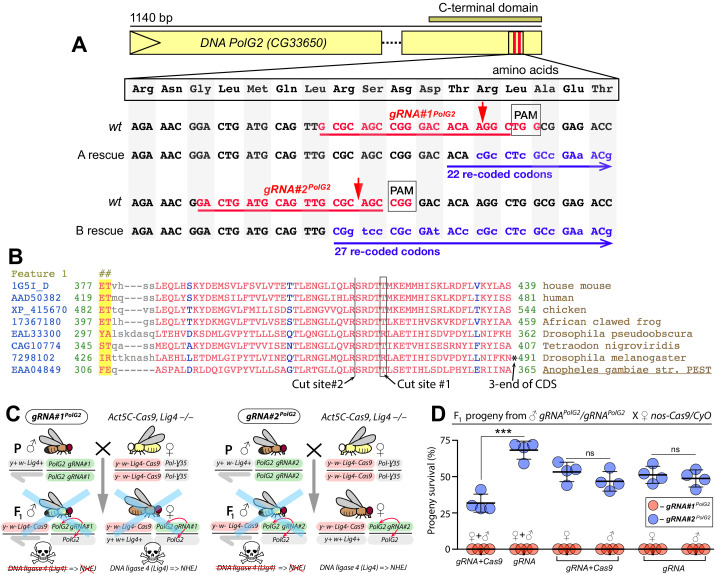
Assessing gRNAs for Cas9-mediated cleavage of PolG2.(A) Schematic map of the DNA polymerase gamma two gene (PolG2). Two gRNAs targeting its C-terminal domain were chosen and tested for guiding Cas9 cleavage. Both gRNA target sites (highlighted in red) are located near the 3’ end of the coding sequence (CDS, B), facilitating re-coding for the rescue allele (highlighted in blue), resistant to Cas9/guideRNA (Cas9/gRNA)-mediated cleavage. Red arrows depict Cas9/gRNA cut sites, which are 13 bases apart. (B) The amino acid sequence alignments of the 3’ end part of the domain (cd02426; Lu et al., 2020) of PolG2 CDS. (C) Genetic crosses to assess the Cas9-mediated cleavage of two gRNAs targeting PolG2 in the DNA ligase four null genetic background (Lig4–/–), in which the non-homologous end-joining (NHEJ) pathway is reduced. Homozygous gRNA#1PolG2 or gRNA#2PolG2 males were crossed to homozygous Act5C-Cas9, Lig4 –/– females, resulting in death of all male progeny for each gRNA. Notably, female progeny harboring gRNA#1PolG2 and Act5C-Cas9 in the Lig4+/– background also perished. (D) The gRNA#1PolG2, but not gRNA#2PolG2, induced lethality of all F1 progeny in conjunction with nos-Cas9 or maternal carryover of the Cas9 protein via lethal biallelic mosaicism (LBM; Kandul et al., 2019). The gRNA#2PolG2 also guided Cas9-mediated lethality in a fraction of trans-heterozygous male and females gRNA#2PolG2/+; nos-Cas9/+ progeny as compared to that in gRNA#2PolG2/+; +/+. The nos-Cas9/gRNA#2PolG2-dependent lethality affected both sexes equally. The plot shows the mean ± standard deviation (SD) over four biological replicates. Statistical significance was estimated using a two-sided Student’s t test with equal variance (p ≥ 0.05ns and p<0.001***). Data depicted in C and D can be found in Supplementary file 2 and Supplementary file 3, respectively.